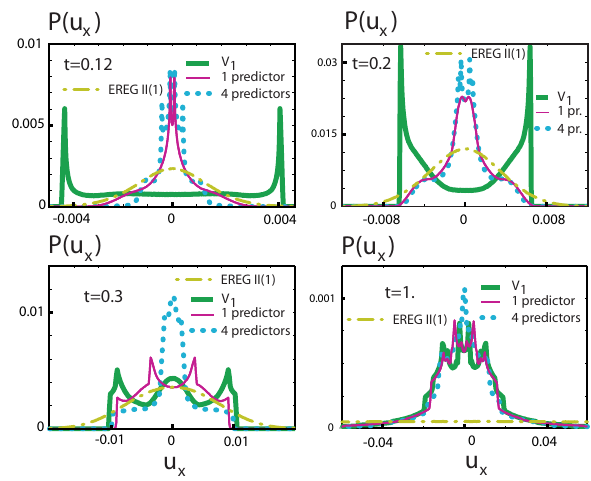
Fig. 6. The distributions of the error variable u x of the Lorenz model with large model error ( (cid:14)r =10 (cid:0) 2 ) and without initialconditionerror,at t =0 : 12 ; 0 : 2 ; 0 : 3 ; 1 . Thelinesindicatedwith“1predictor”and“4predictors” applytoallregressionmethodsexceptforGMandEREGII.Theresultsaregeneratedusing 2 (cid:2) 10 6 ensembles.